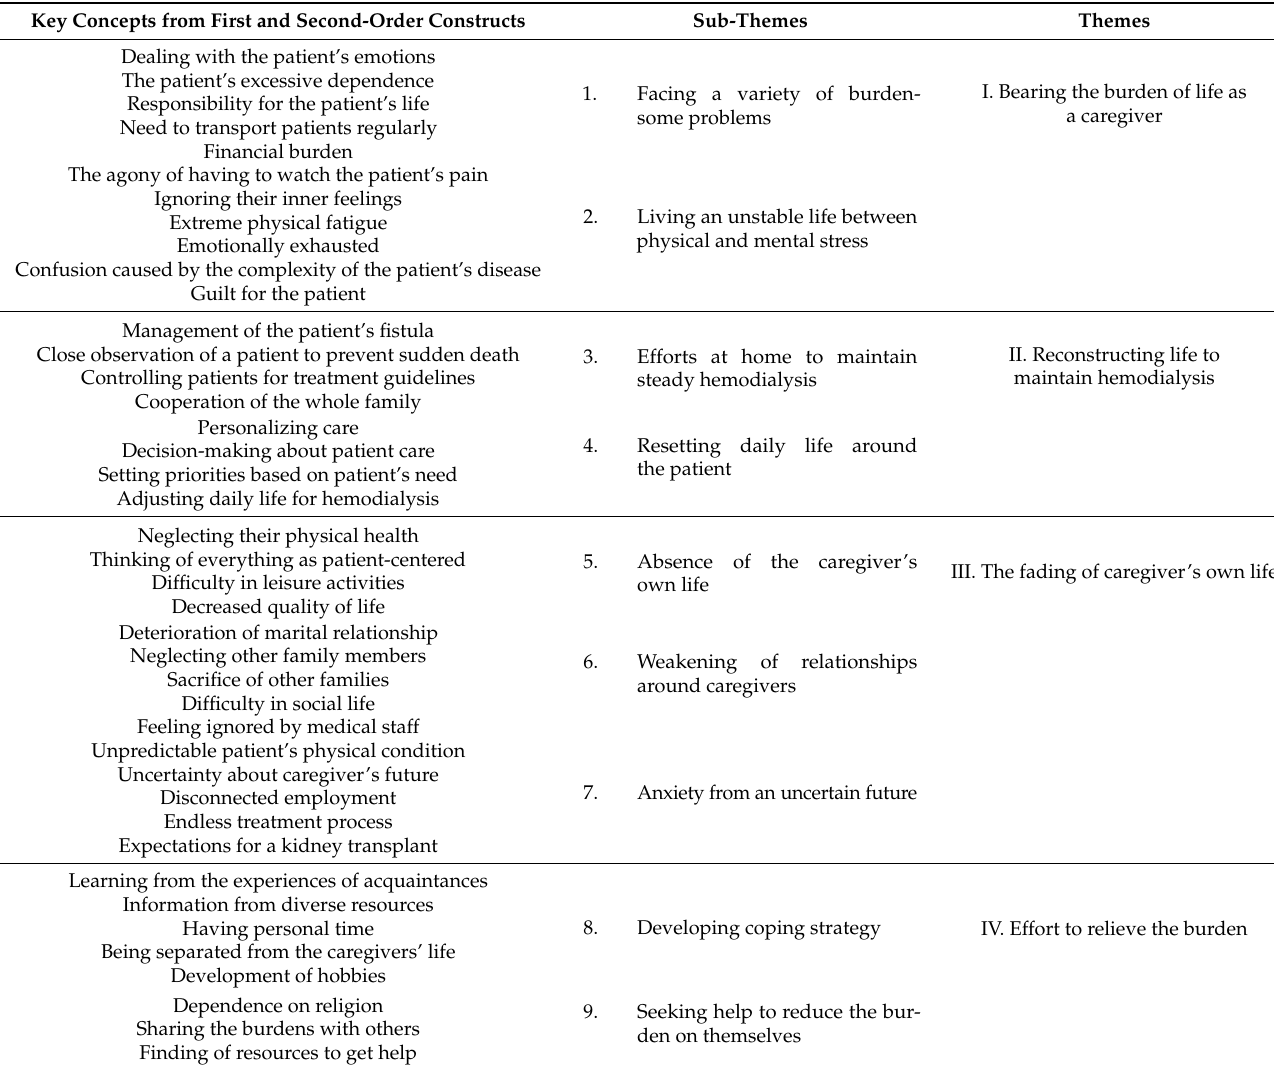
Table 3. Family caregivers’ experiences of caring for patients with